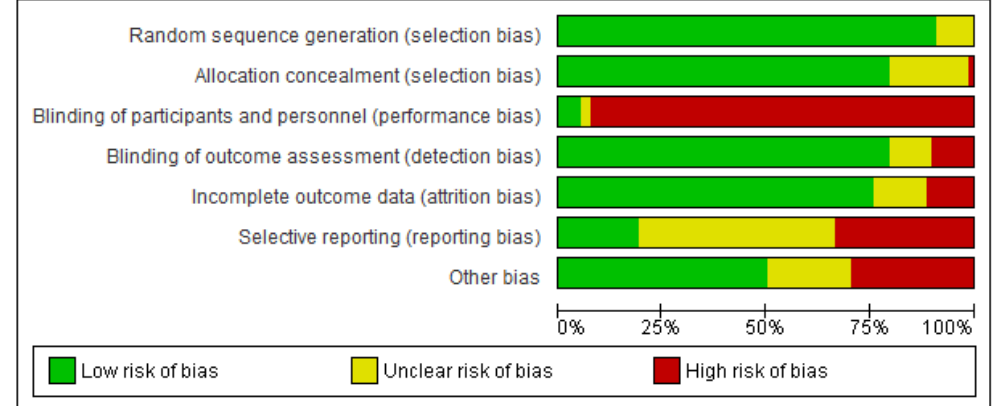
Figure 3. Risk of bias assessment across included studies